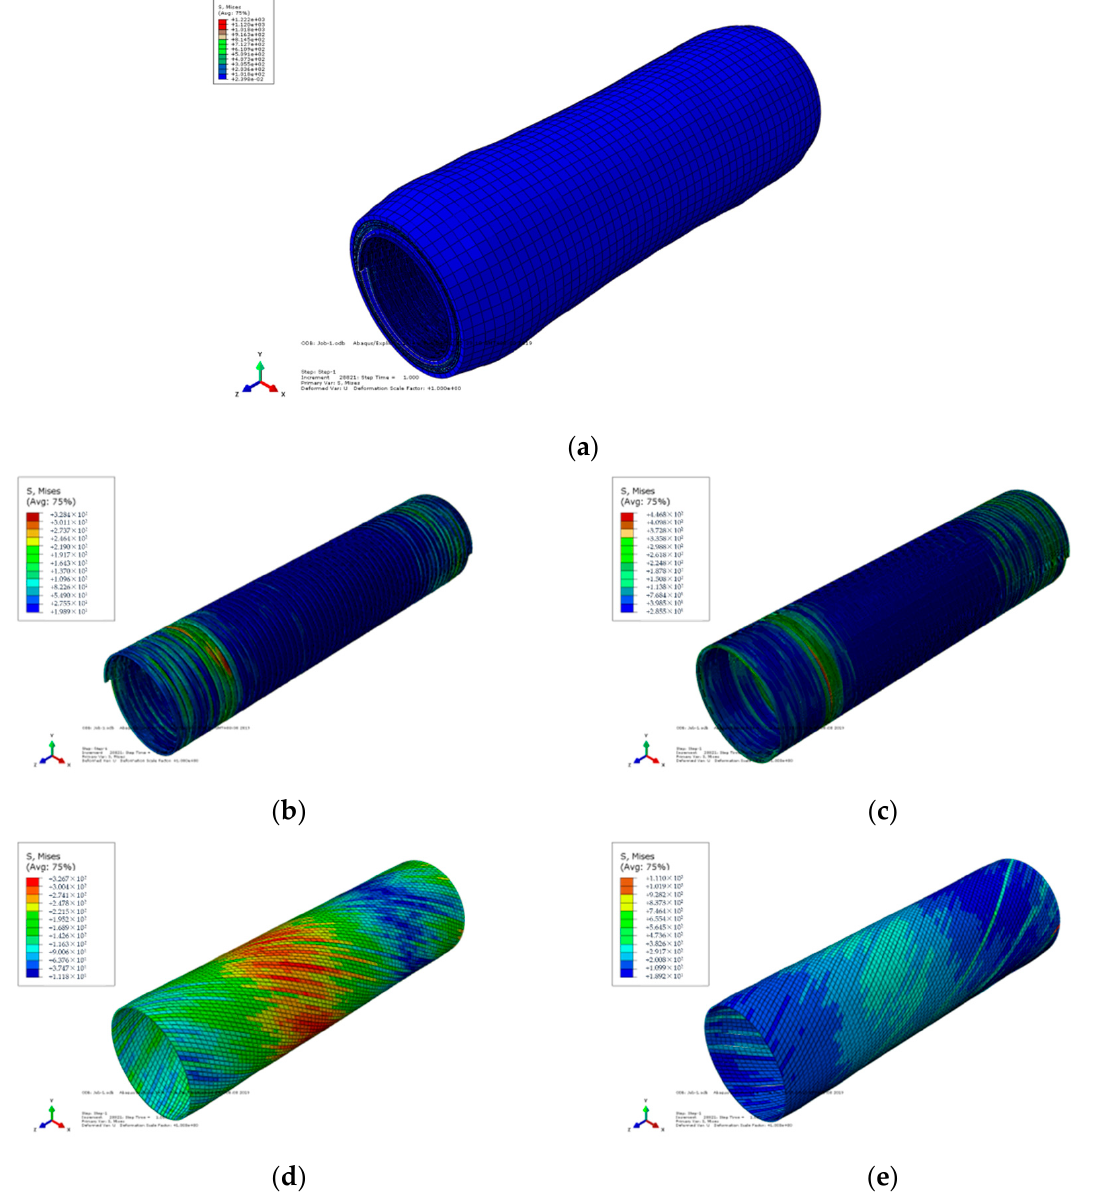
Figure 7. A stress nephogram under axial pressure. ( a ) The riser; ( b ) Skeleton layer; ( c ) Compressive armor layer; ( d ) Internal tensile armor layer; ( e ) External tensile armor layer. The structural stress of each metal layer under the bending moment is as Figure 8 .